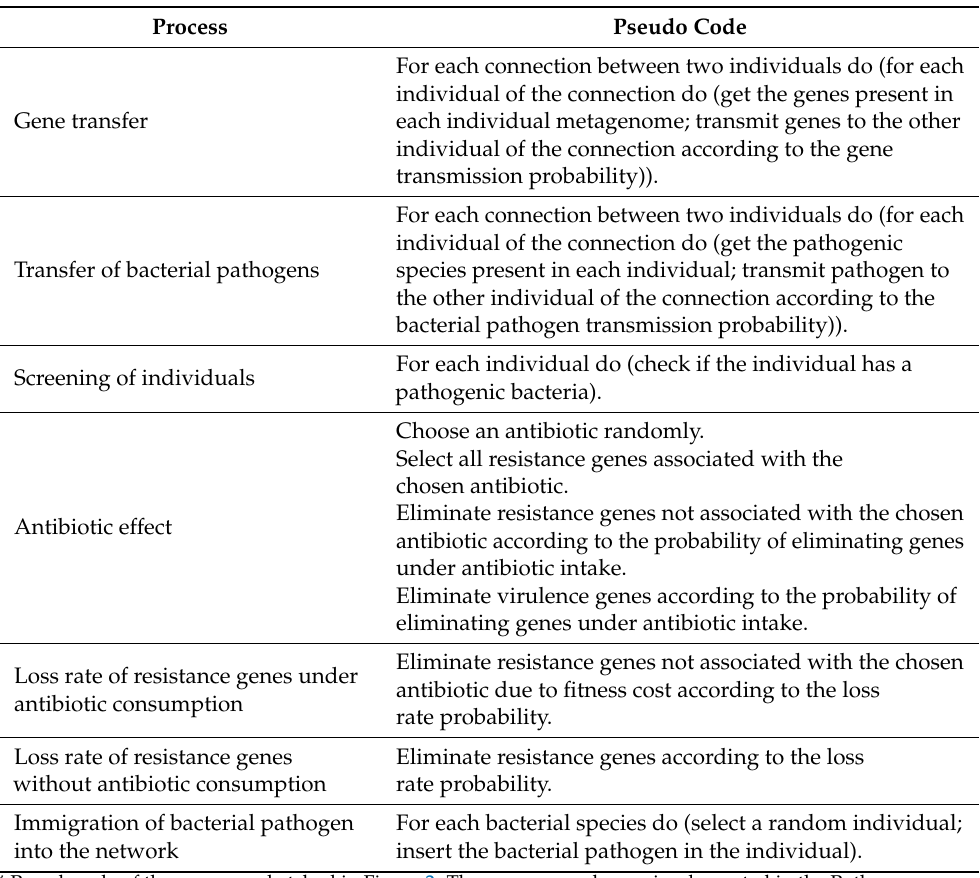
Table 1. Pseudocode of the program